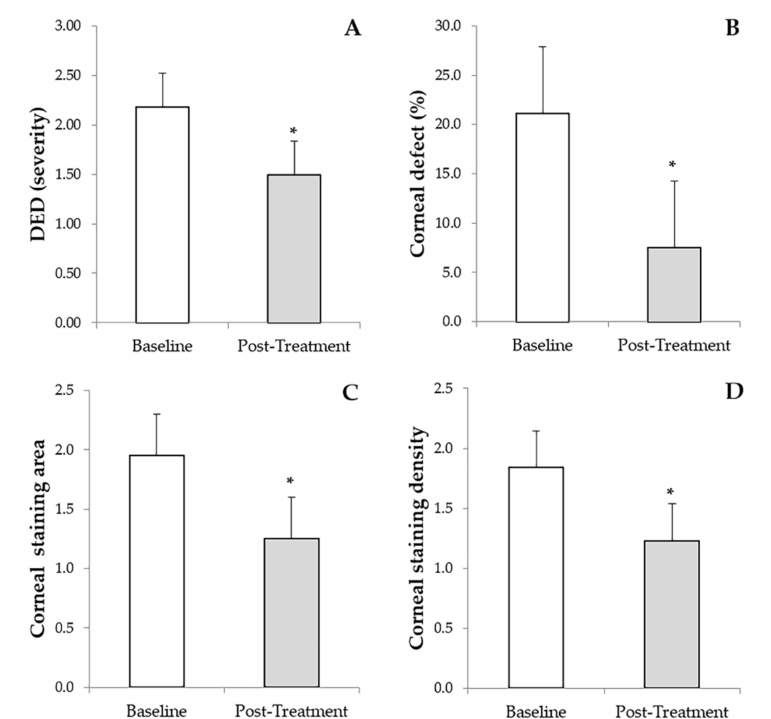
Figure 1. Results of the primary outcome measures before and after treatment with PRGF eye drops and RGTA. ( A ): Dry eye disease (DED). ( B ): Percentage of the corneal defect. ( C ): Corneal staining area. ( D ): Corneal staining density. * Statistically significant differences ( p < 0.05) before versus after treatment with PRGF and RGTA.